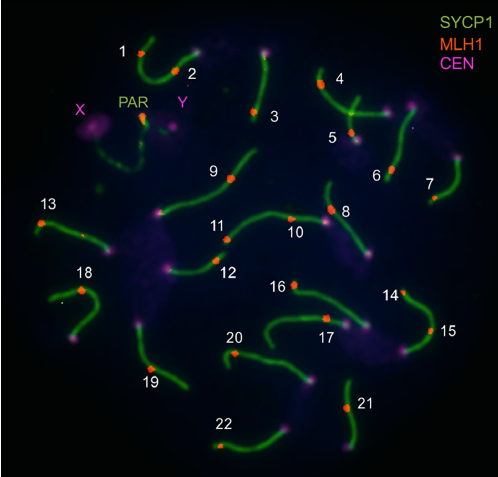
Fig 1. Image illustrating immunofluorescent cytology approach to measuring the genome-wide recombination rate (from Balcova et al., 2016). Pachytene spread of a spermatocyte from the C57/BL6 strain shows central elements of synaptonemal complexes of 19 autosomes and the pseudoautosomal region (PAR) immunostained for SYCP1 (green), MLH1 foci (red), and foci of centromeric proteins (violet). The number of MLH1 foci is used as an equivalent of the number of